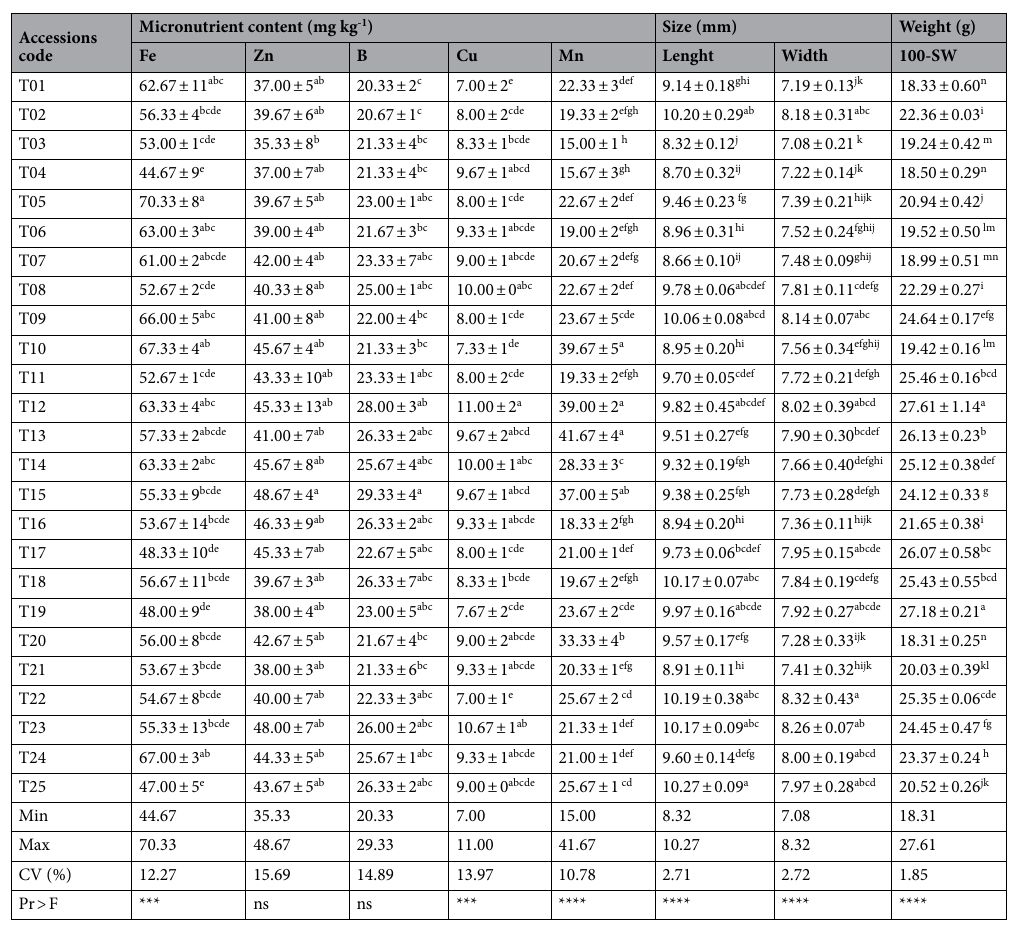
Table 2. Genotype by trait data for 25 late-flowering accessions of L. mutabilis for eight traits. Data are expressed as mean ± SD. Significant differences between treatments ( P < 0.05) are indicated by different letters (ns: no significant differences; *** p < 0.001 and **** p <